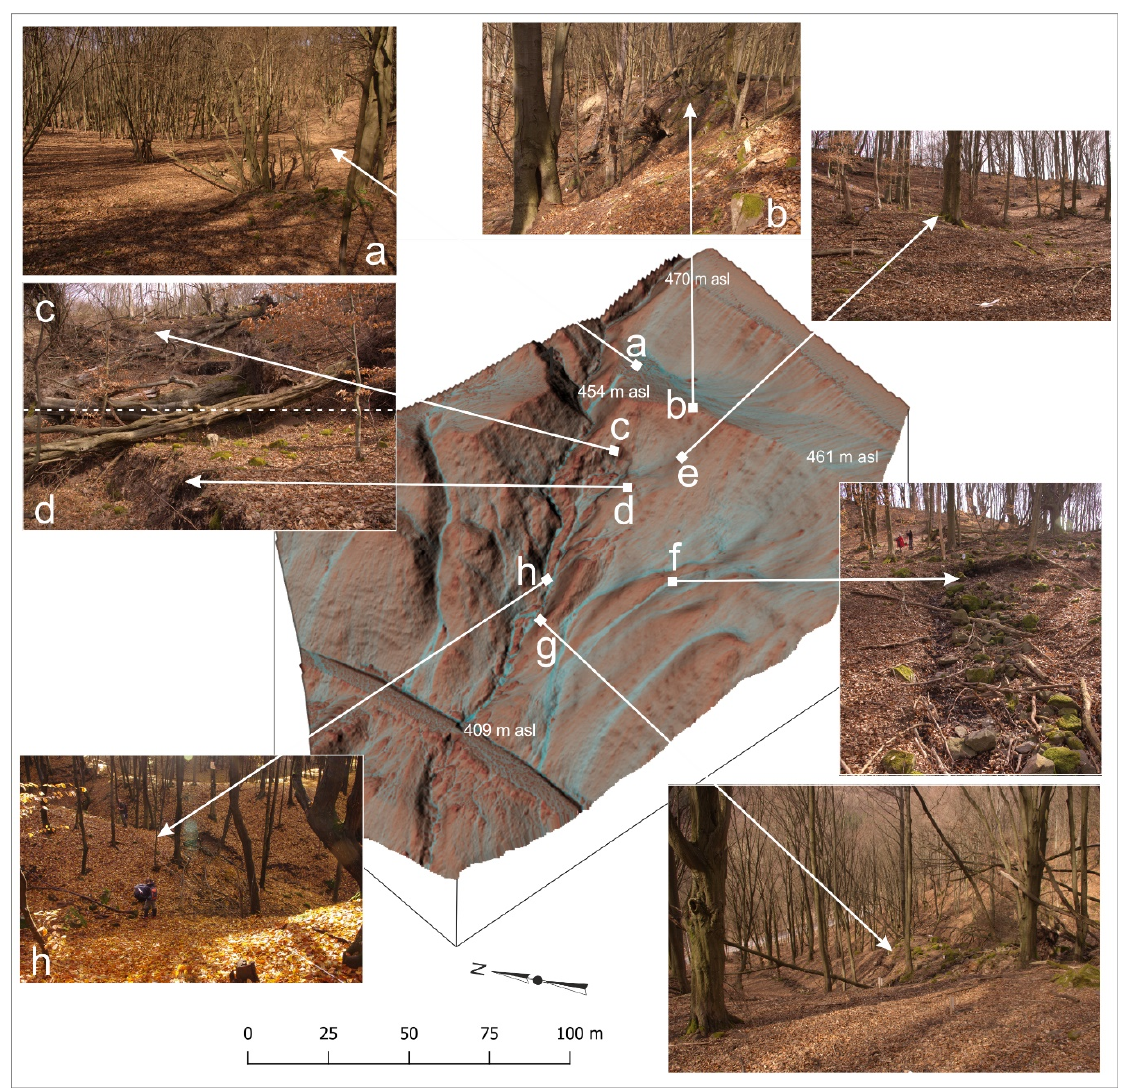
Figure 2. An active gully-related landslide system and micro-scale landforms features indicating its activity: ( a ) A collapsed sink; ( b ) terrain edge and exposed substrate and a bedrock; ( c ) a major scarp; ( d ) a minor scarp; ( e ) a terrain depression; ( f ) a spring with occasional water flow; ( g ) a ridge; and ( h ) a junction of gullies.